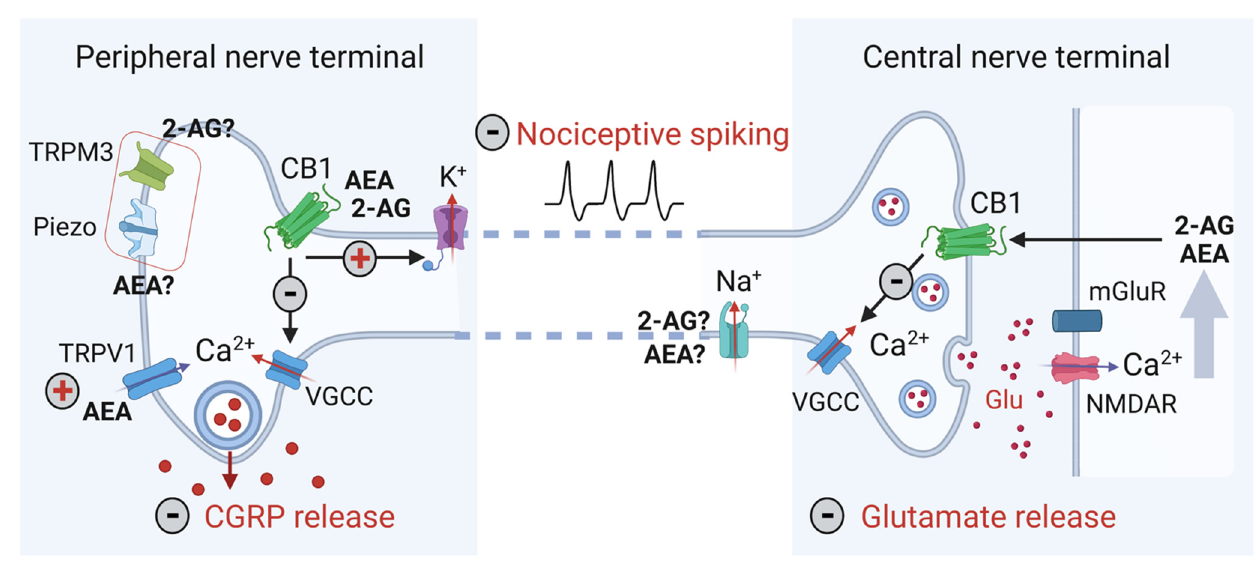
Figure 3. EndoCBs interfere with multiple ion channels in peripheral migraine pain mechanisms. Nociceptive spiking, Ca 2+ -dependent CGRP release in the peripheral nerve terminal (left), and glutamate release in the central nerve terminal (right), are the main targets for endoCBs leading to pain inhibition. In the peripheral nerve terminal, the activation of CB1 receptors by endoCBs results in the inhibition of voltage gated calcium ion channels (VGCC), resulting in reduced CGRP release. The CB1-mediated opening of potassium ion channels reduces excitability and diminishes nociceptive spiking. AEA also acts as a direct agonist of TRPV1 receptors, thus opposing peripheral anti-nociception via CB1 mechanism. Peripheral terminals also express mechanosensitive TRPM3 and Piezo ion channels (in the red box), which can potentially be modulated by endoCBs through modifications of the lipidic environment. In the central nerve terminal, glutamate release stimulates endoCBs synthesis by postsynaptic Ca 2+ influx through NMDA receptor and PLC enhancement following mGluR activation. EndoCBs retrogradely approaching presynaptic terminals reduce glutamate release by blocking VGCC. The action of endoCBs is mediated by CB1 receptors but they can also work as allosteric modulators, directly targeting sodium ion channels and thus, further affecting the generation and propagation of nociceptive spikes. Plus (+) and minus ( − ) symbols indicate the enhancement or inhibition of ion channels by endoCBs, respectively.